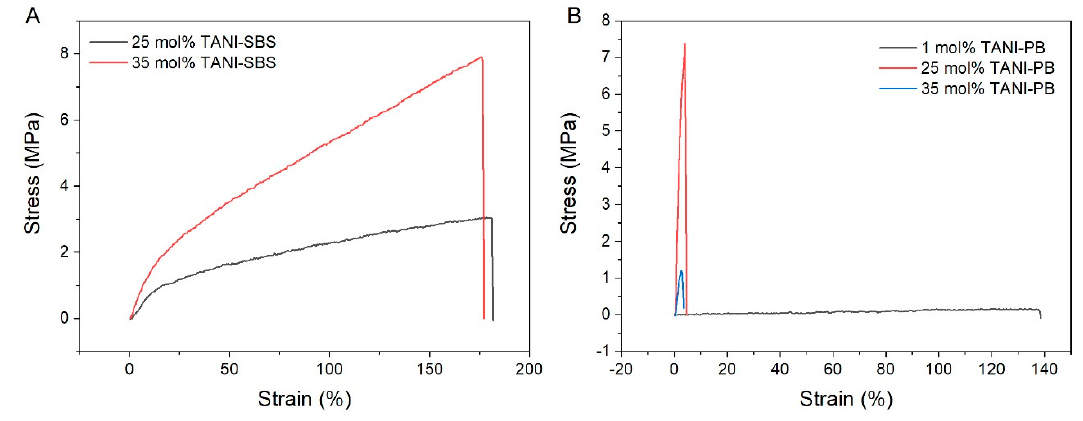
Figure 5. Stress–strain curves for ( A ) 25 mol% TANI SBS, 35 mol% TANI-SBS, and ( B ) 1 mol% TANI-PB, 25 mol% TANI-PB, 35 mol% TANI-PB.